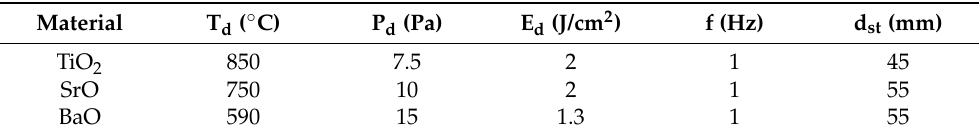
Figure 5. AFM images of (001) NdGaO 3 substrates (cut from the same larger wafer) characterized by an angle ∆ of 45 ◦ : ( a ) chemically etched for 2 min in m-BHF solution and annealed for 2 h at 1000 ◦ C in air, ( b ) only annealed for 2 h at 1000 ◦ C in air. AFM scans size: ( a ) 7 × 7 µ m 2 , and ( b ) 5 × 5 µ m 2 . Table 2. Deposition parameters for the MeO (Me = Ti, Sr, Ba) thin films. T d = deposition temperature, P d = deposition pressure (O 2 gas), E d = laser energy density on target, f = laser repetition rate, d ts = substrate–target distance.